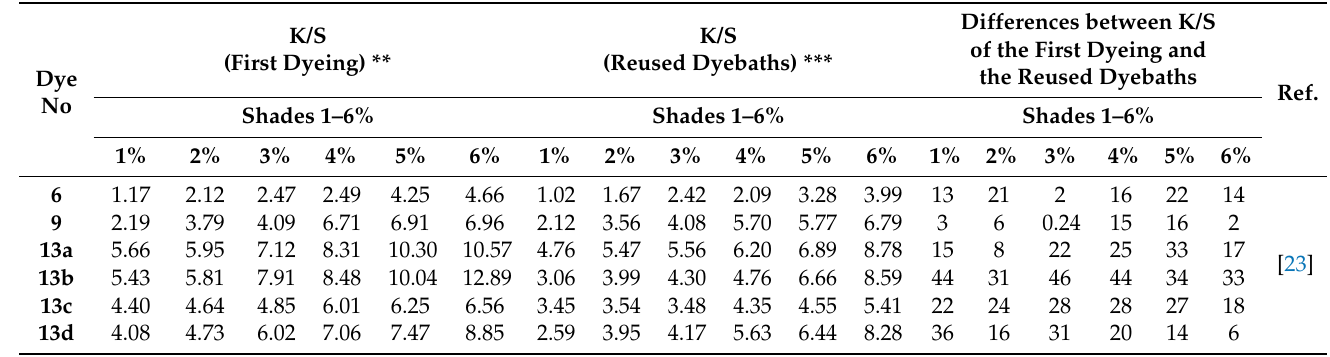
Table 3. K/S of polyester fabrics * dyed with dyes 6 , 9 and 13